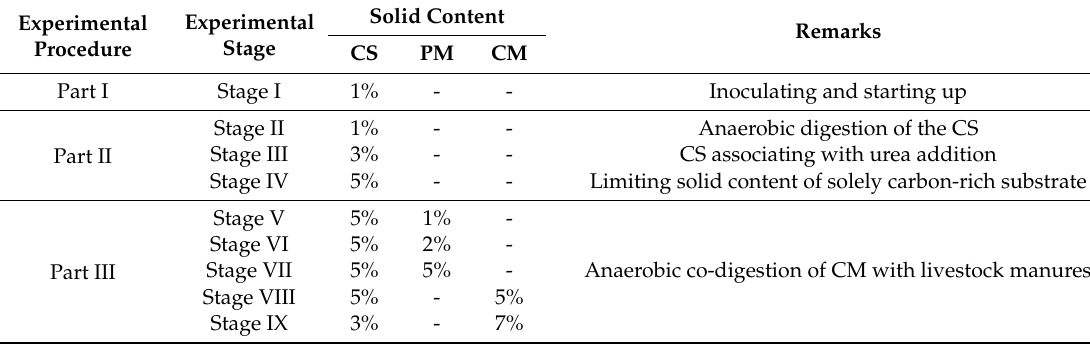
Table 3. Experimental design for the pilot-scale anaerobic digestion